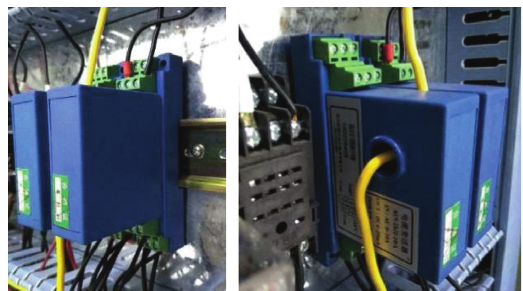
Figure 3: Voltage transmitter and current transmitter installation